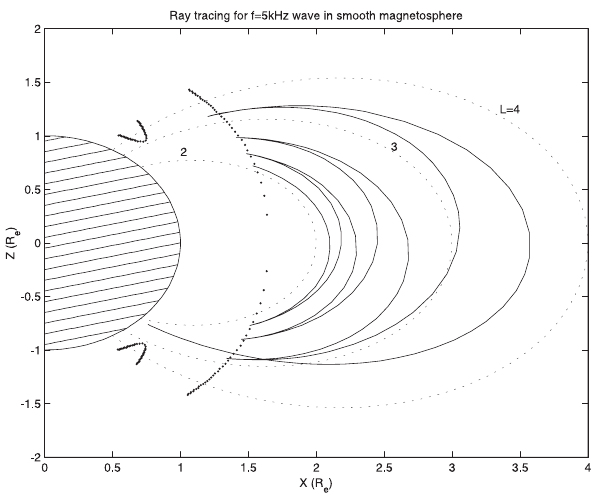
Fig. 8. Propagation paths for the wave with frequency f = 5 kHz calculated without taking into account the plasmapause. The con- tour corresponding to LHR frequency 5 kHz in the model used in calculations is shown by dotted line.